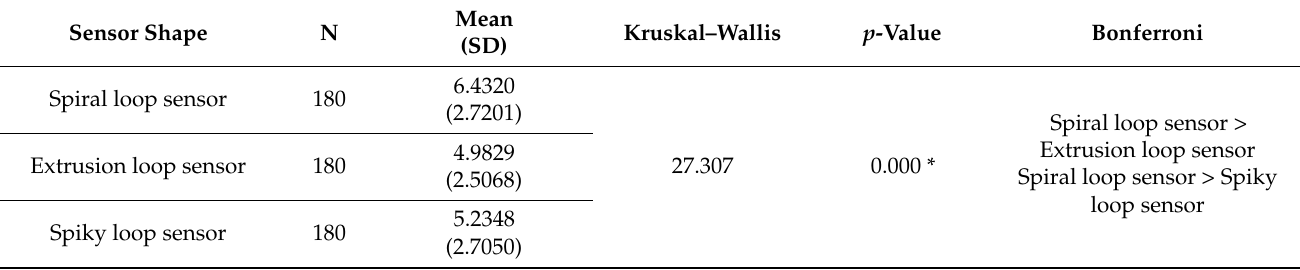
Table 3. Efficiency evaluation of cardiac activity signals according to the shape of the fabric loop sensor.